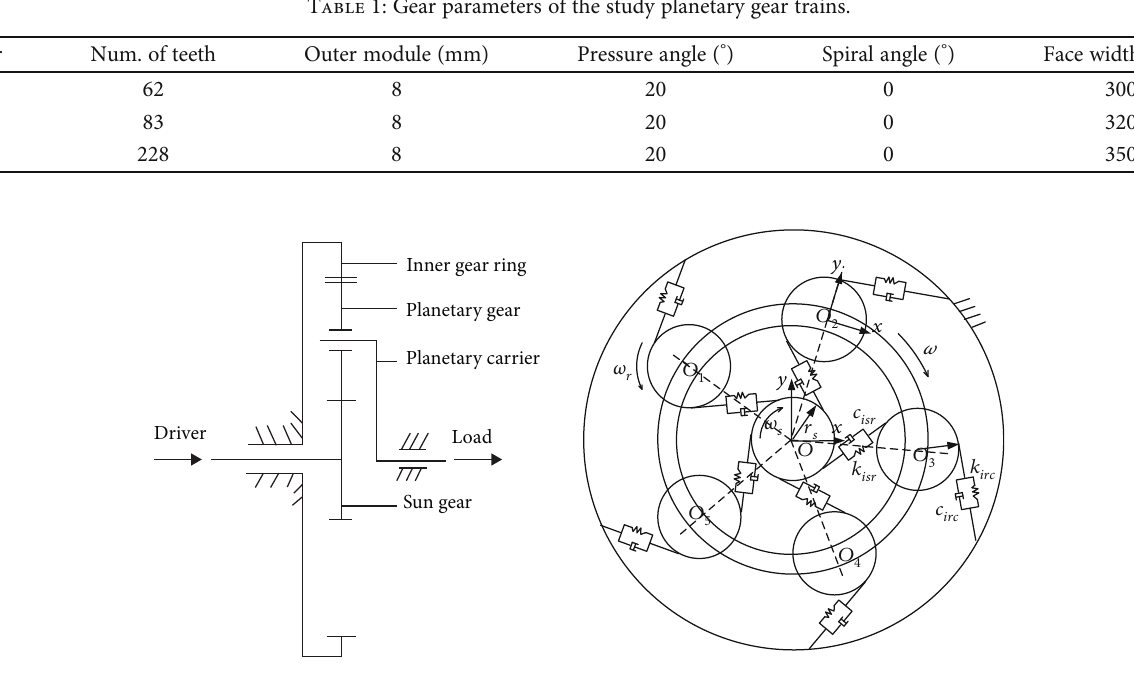
Figure 2: Dynamic theoretical model of the planetary gear